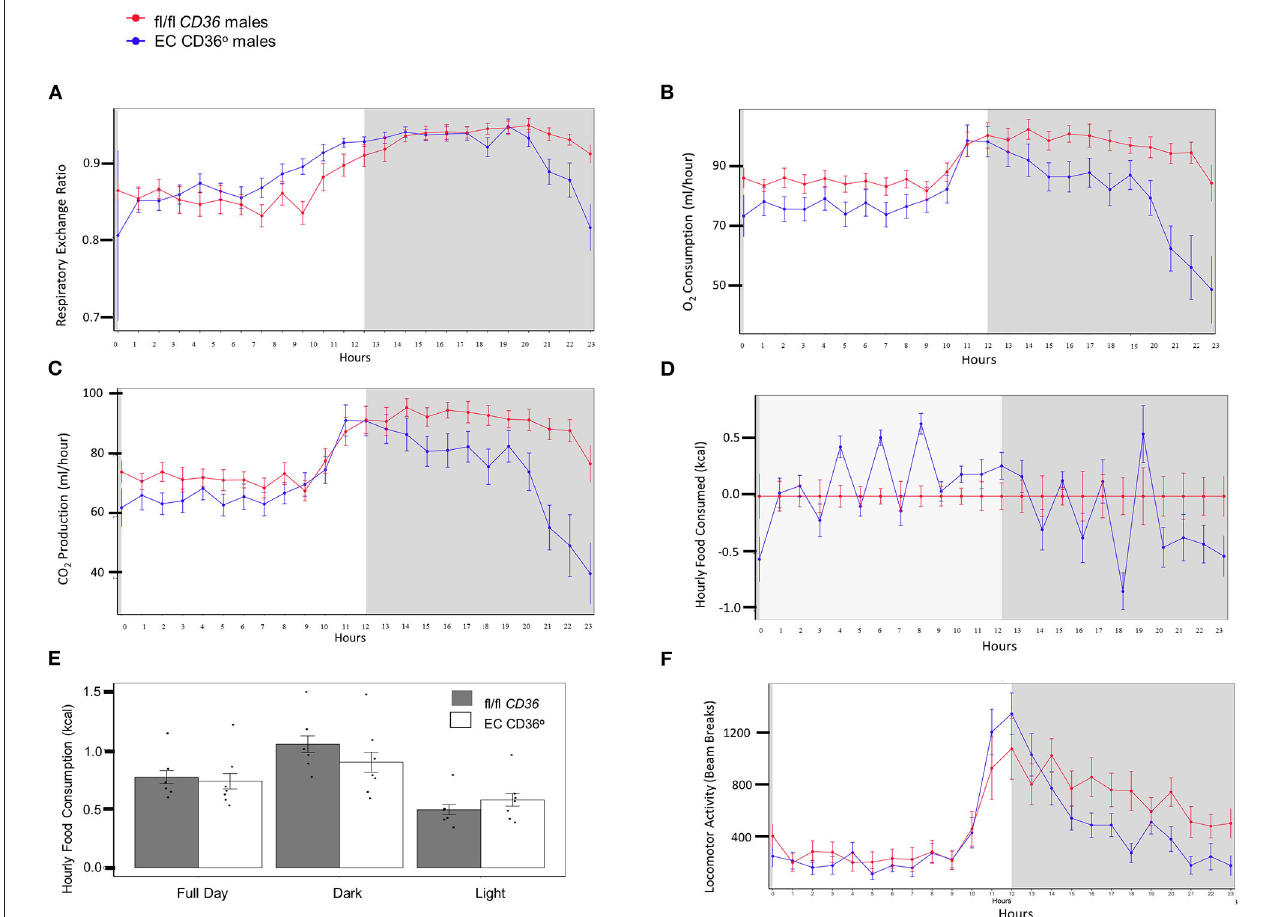
FIGURE 3 | Indirect calorimetry of 4-week-old normal chow-fed male fl/fl CD36 ( n = 6) and EC CD36 ◦ ( n = 7) mice. Plots show data from a 12h light:12h dark cycle after a 24h acclimation period. White panel = light phase; gray panel = dark phase. (A) Respiratory exchange ratio, (B) oxygen consumption, (C) CO 2 production, (D) food consumption, (E) total food consumption, and (F) locomotor activity.